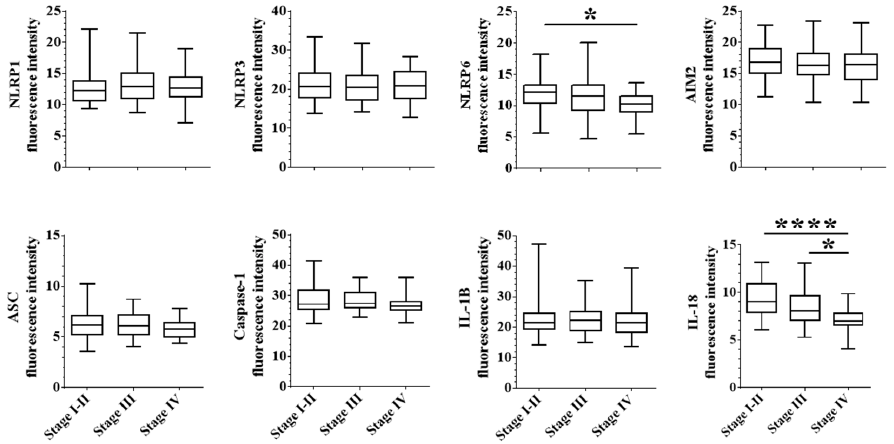
Figure 3. Epithelial expression of NLRP6 and IL-18 are correlated with tumor evolution. For each protein, we assessed the correlation between fluorescence intensity and tumor stages, classified in stage I-II (locally advanced), stage III (regionally advanced) and stage IV (metastatic disease). A one-way ANOVA (parametric) or Kruskal-Wallis (unparametric) tests were used to evaluate the significance of the di ff erential expression between each disease stage. * p < 0.05 and **** p <